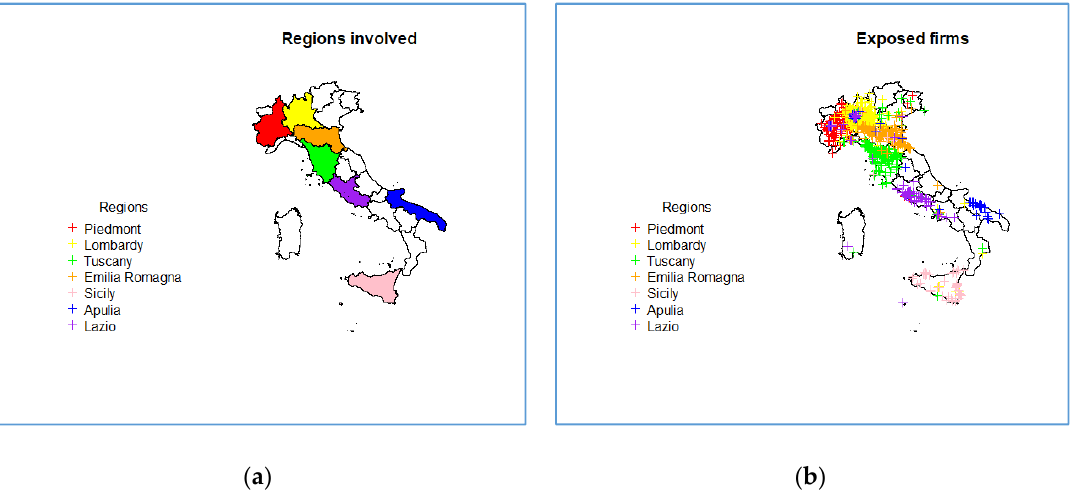
Figure 4. ( a ) Italian map of regions involved in the study. ( b ) Italian map with the spatial distribution of exposed firms.